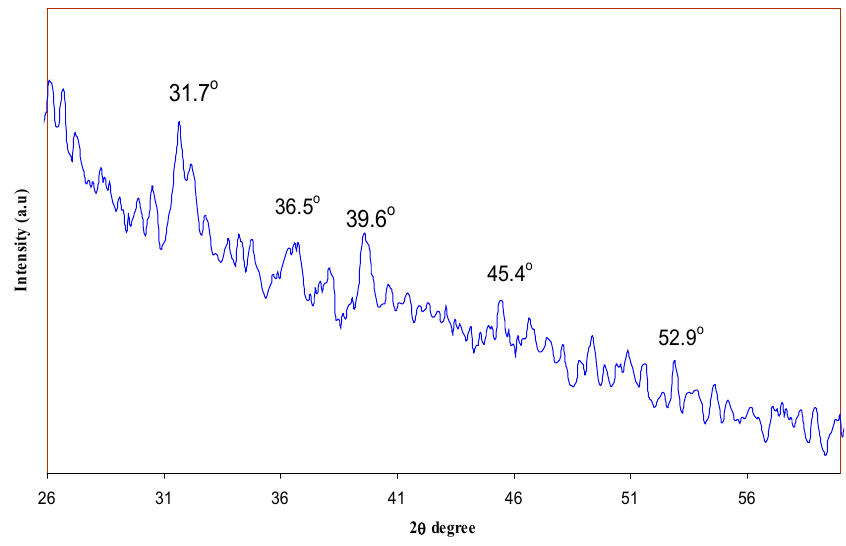
Figure 11. XRD pattern of pure MC and doped MC samples.